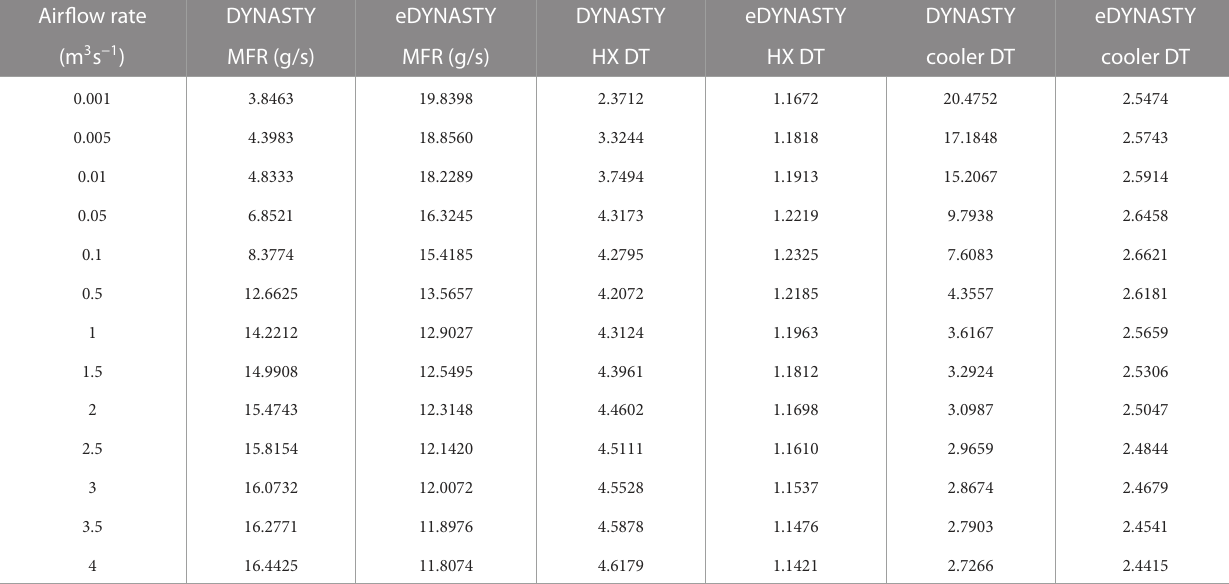
TABLE1 DYNASTYcoolerparametricanalysisresults,massflowrate(MFR),andtemperaturedifferences(DT). Airflow rate